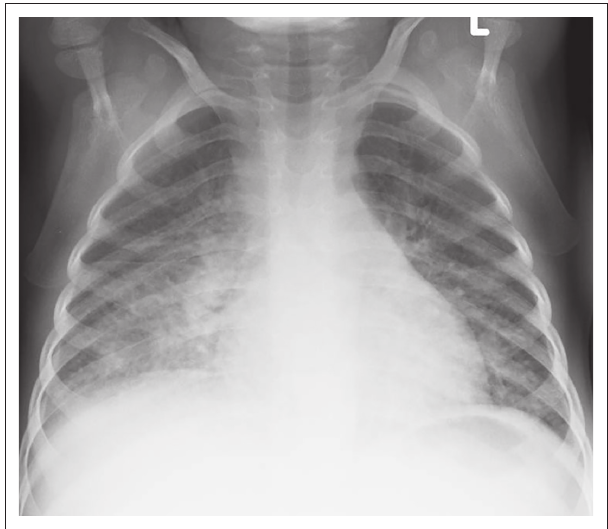
FIGURE 8: 6-year-old boy infected with HIV and severe immunosuppression who presented with a violaceous mass in the upper airway. Frontal chest radiograph shows reticulo-nodular perihilar opacities predominately located in the lower lung zones, right hilar lymphadenopathy, and bilateral effusions. The final diagnosis was pulmonary Kaposi